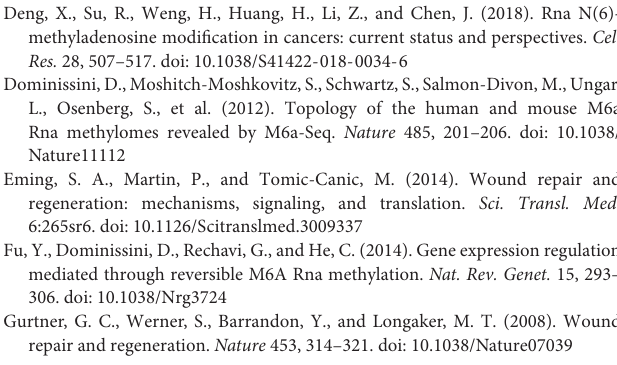
Supplementary Figure 1 | Gene ontology enrichment of altered m 6 A transcripts. (A) Gene ontology (GO) analysis of the cellular component involved in up-methylated genes in HS samples conducted by top GO. (B) GO analysis of the cellular component involved in down-methylated genes in HS samples conducted by top GO. (C) GO analysis of the molecular function involved in up-methylated genes in HS samples conducted by top GO. (D) GO analysis of the molecular function involved in down-methylated genes in HS samples conducted by top GO. Supplementary Figure 2 | Gene ontology enrichment of altered mRNA transcripts. (A) Gene ontology (GO) analysis of the cellular component involved in upregulated genes in HS samples conducted by top GO. (B) GO analysis of the cellular component involved in downregulated genes in HS samples conducted by top GO. (C) GO analysis of the molecular function involved in upregulated genes in HS samples conducted by top GO. (D) GO analysis of the molecular function involved in downregulated genes in HS samples conducted by top GO. HS, hypertrophic scar. Supplementary Figure 3 | Gene ontology enrichment of altered m 6 A and mRNA transcripts in hypertrophic scar samples compared with normal skin tissues. (A) Gene ontology analysis of the cellular component involved in “hyper-up” genes in HS samples conducted by top GO. (B) GO analysis of the cellular component involved in “hypo-down” genes in HS samples conducted by top GO. (C) GO analysis of the molecular function involved in “hyper-up” genes in HS samples conducted by top GO. (D) GO analysis of the molecular function involved in “hypo-down” genes in HS samples conducted by top GO. HS, hypertrophic